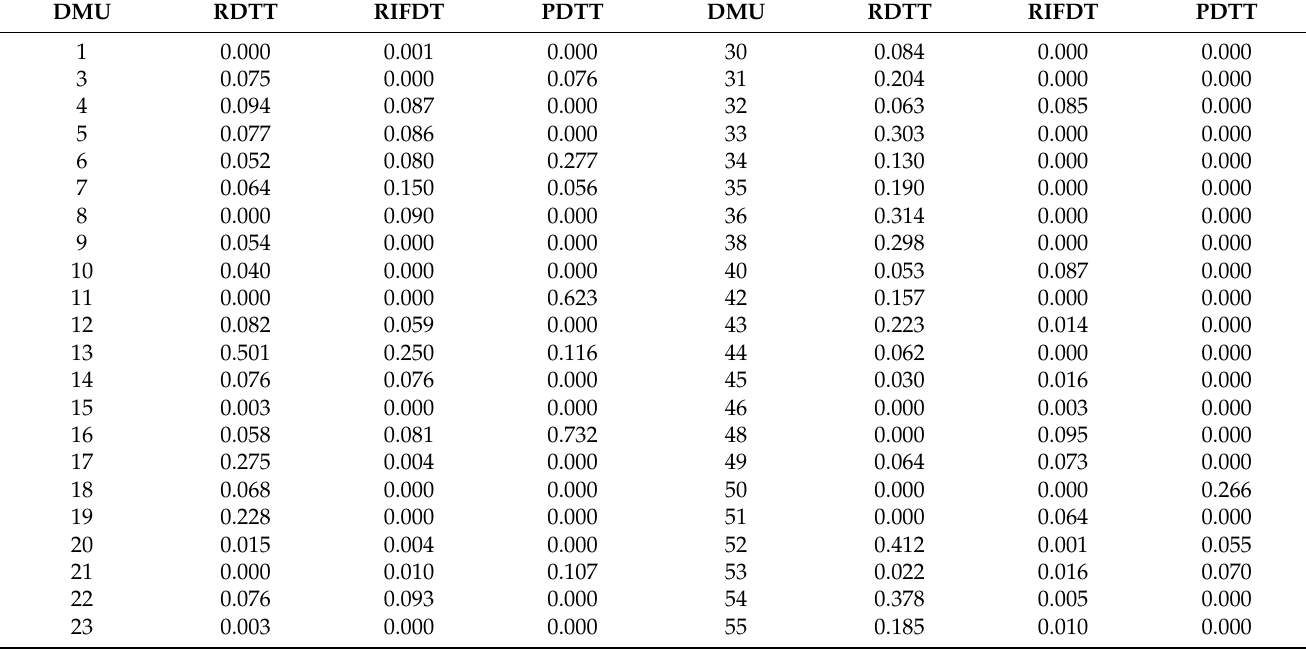
Table 4. Analysis results of inefficient